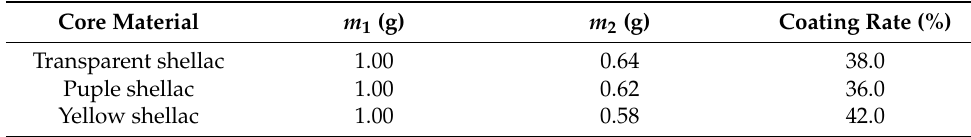
Table 2. Coating rate results of different microcapsules.